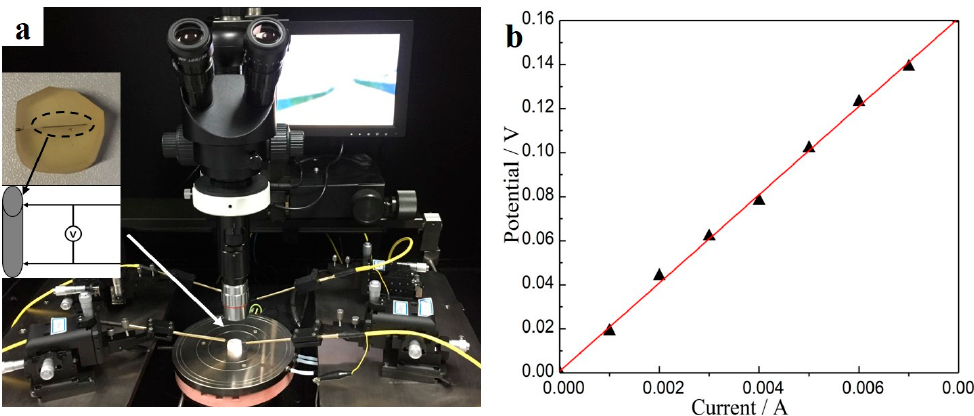
Figure 10. ( a ) The test platform of a single micro-pillar and ( b ) the potential–current curve of a single micro-pillar.